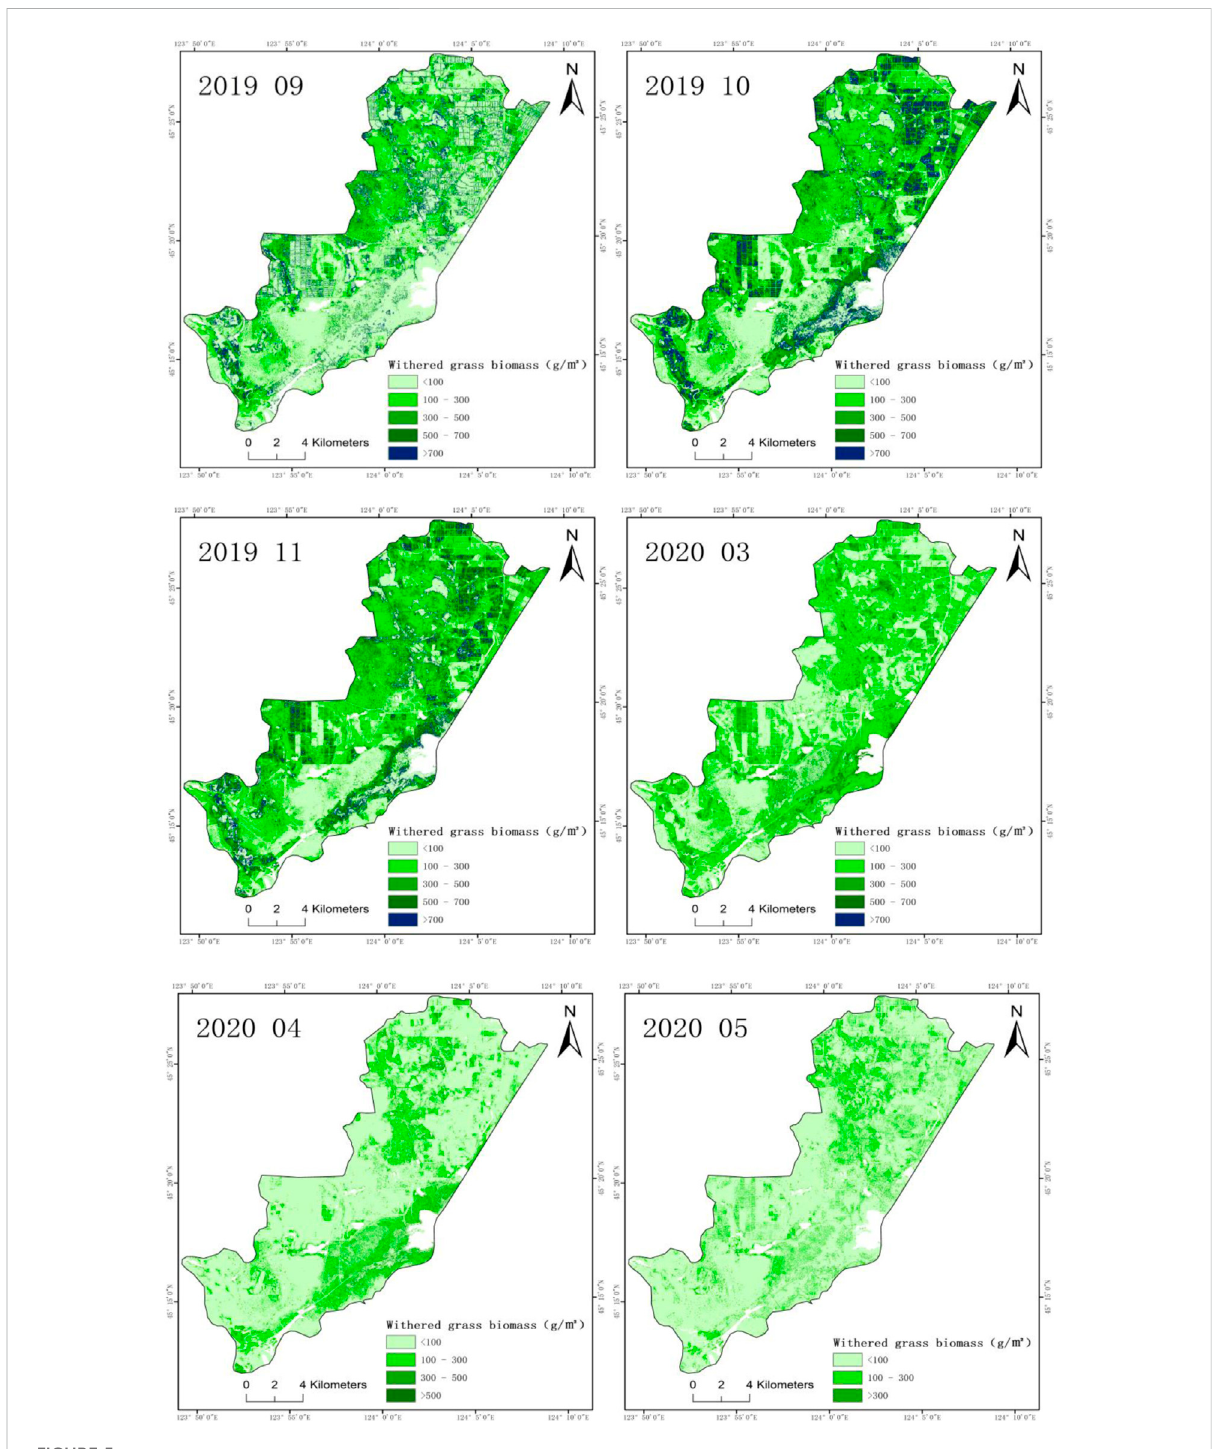
FIGURE 5 Spatial distribution of the dry-grass